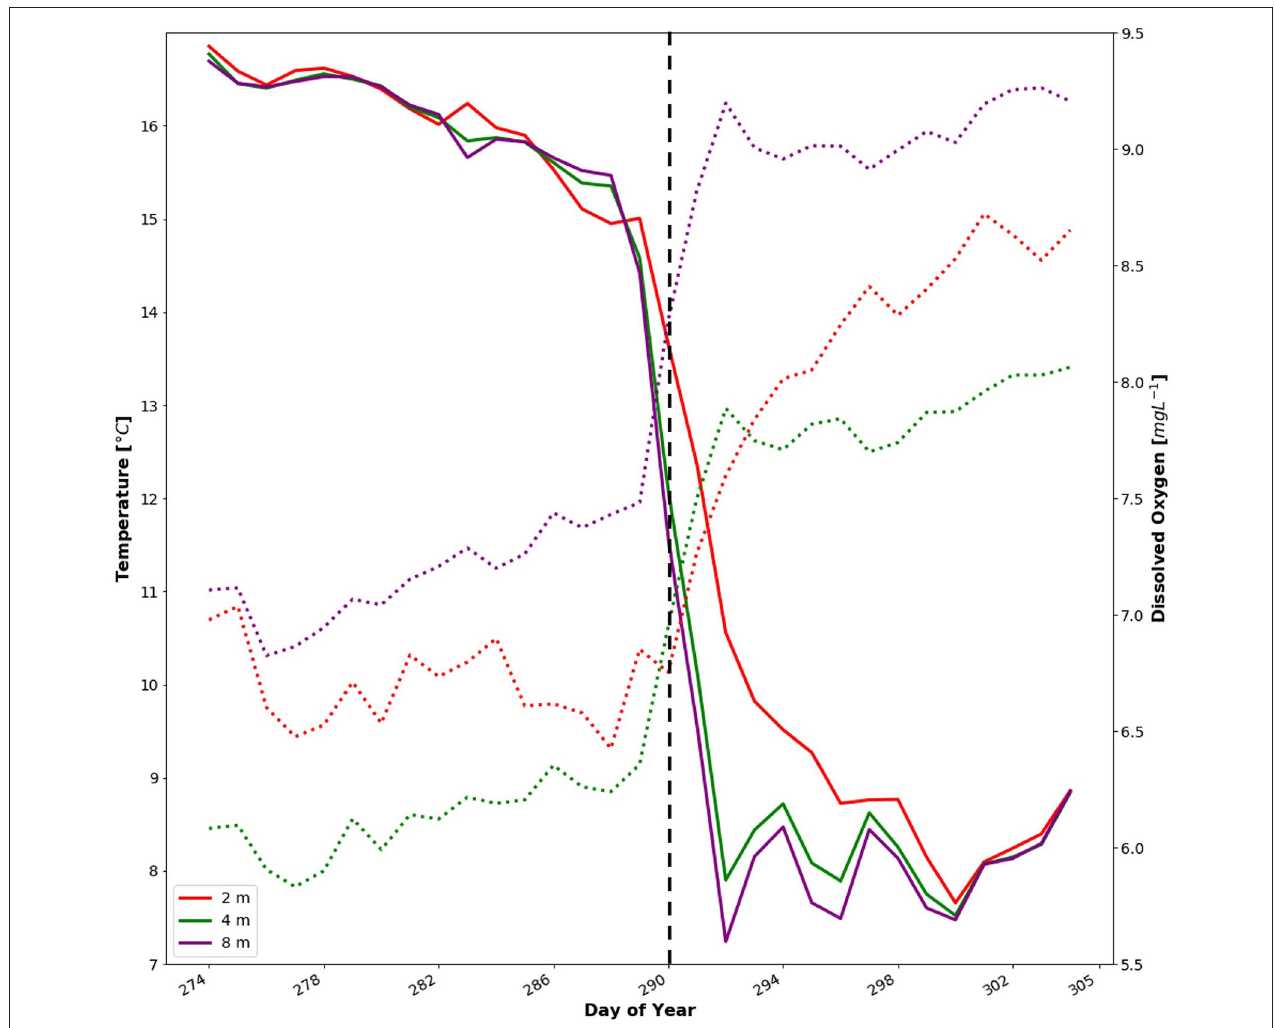
FIGURE 6 | Daily average of temperature [ ◦ C] (solid lines) and dissolved oxygen [mgL − 1 ] (dotted lines) measured in study cage at 2m (red), 4m (green), and 8m (purple) depth (adapted from Burke et al., 2021). Vertical black line denotes split between before and after the fall overturn.